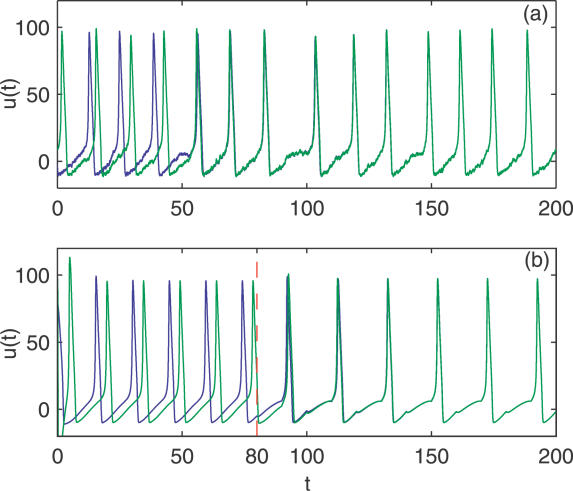
Synchronization of Two HH Neural Oscillators(A) Driven by common Gaussian white noise; and (B) driven by a common square wave.